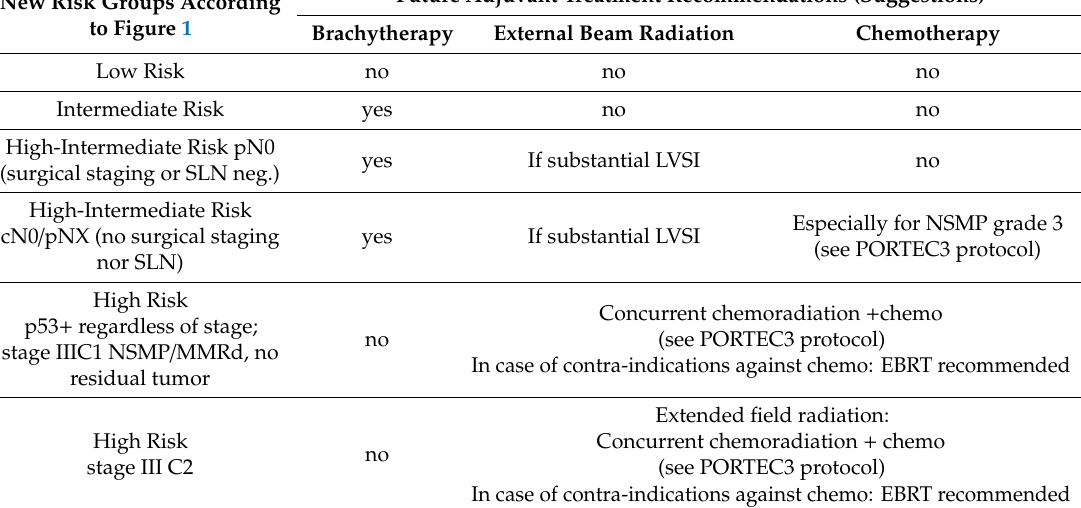
Table 2. Suggestions for future recommendations for adjuvant treatment according to the new risk